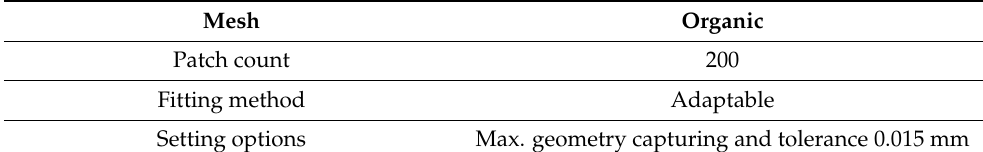
Table 4. NURBS parameters.